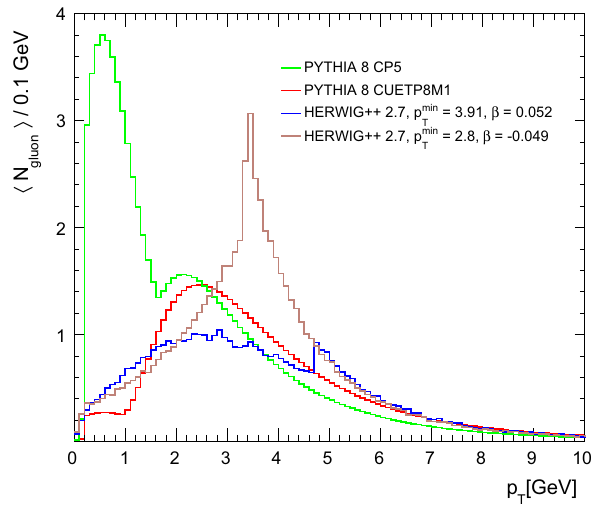
Fig. 1 p T distribution of gluons coming from primary and MPI inter- actions. The pseudorapidity range is | η | < 5. We show two different settings (tunes) for the Pythia 8 [7,9] and Herwig++ 2.7 [10] MC